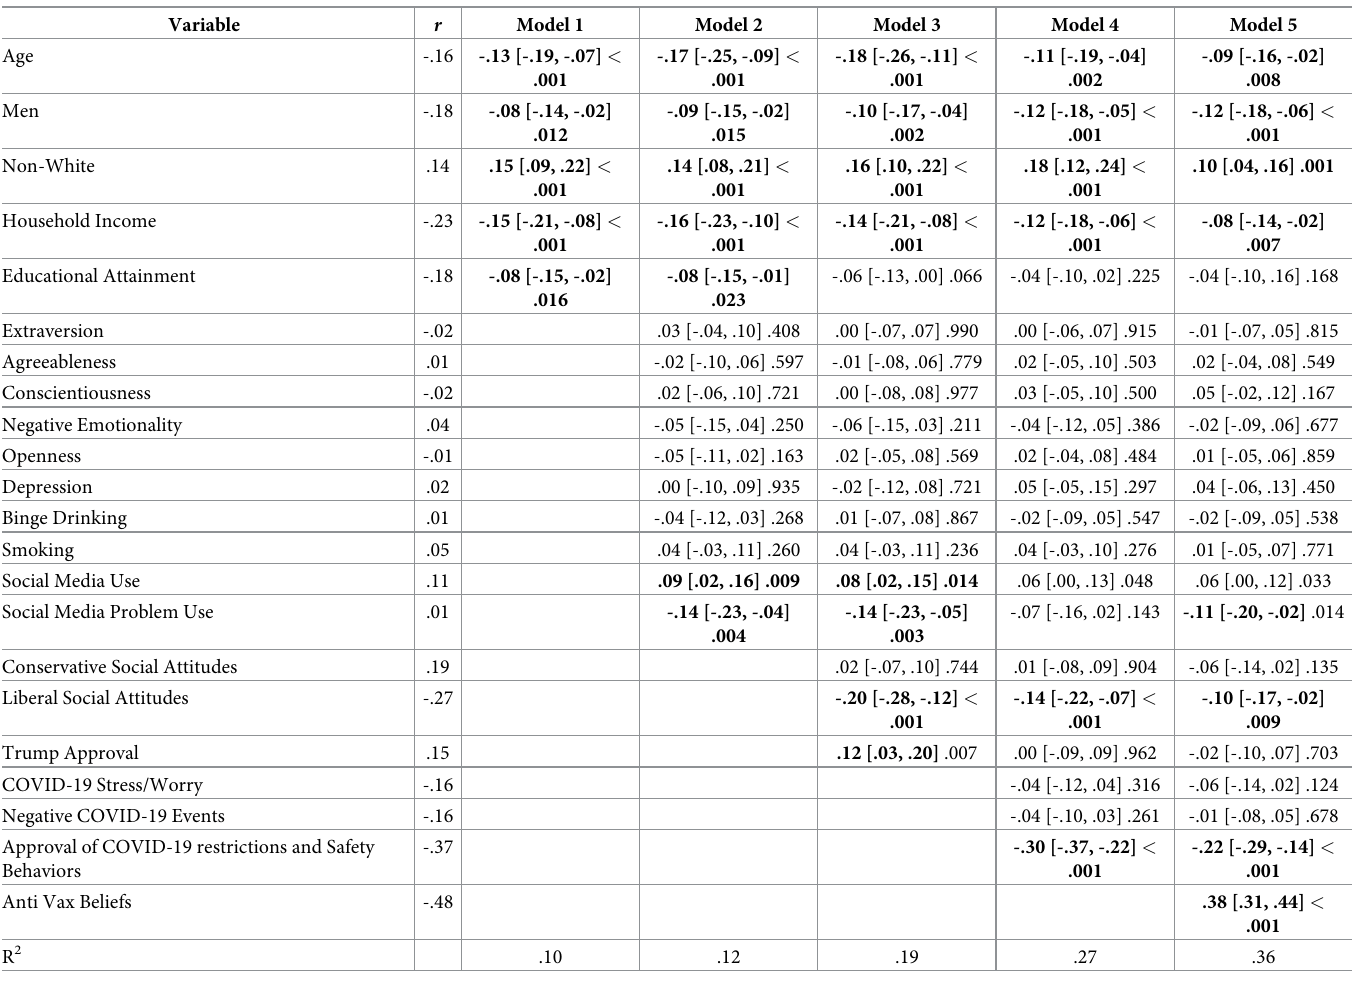
Table 6. Standardized regression coefficients from COVID-19 vaccine hesitancy